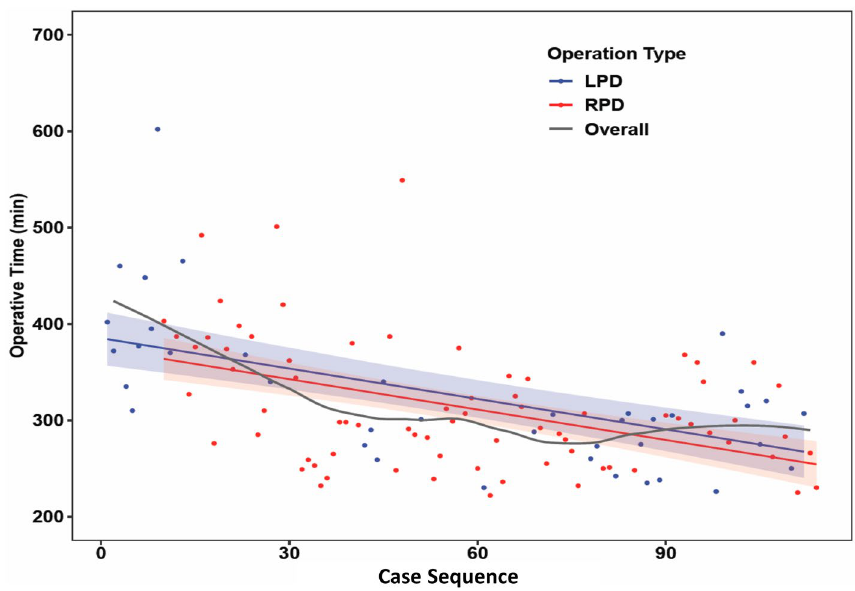
Figure 1. The operative time versus patient sequence of MIPD in a scatter plot. The black line showed the moving average of the operative time. The blue and red solid line presented as the regression line of operative time and the operative time was decreasing for both LPD (blue) and RPD (red).